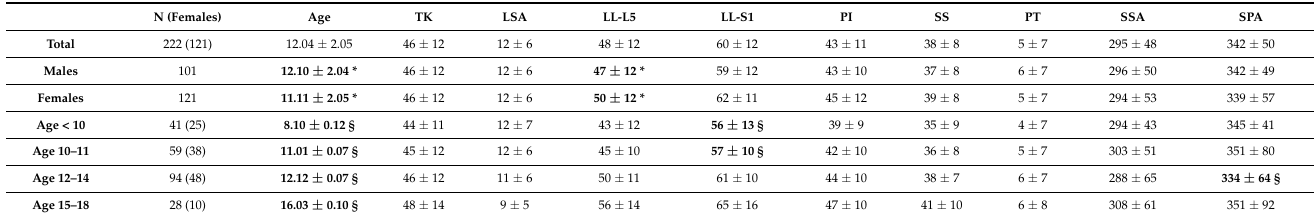
Table 1. Characteristics of the study population according to gender and age groups.